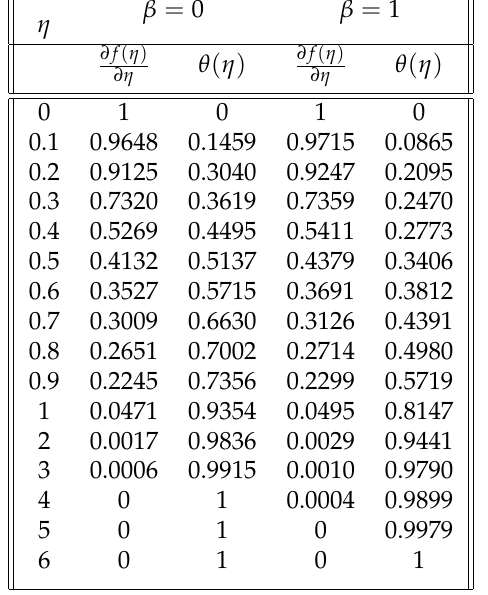
Table 5. Values of − ∂θ